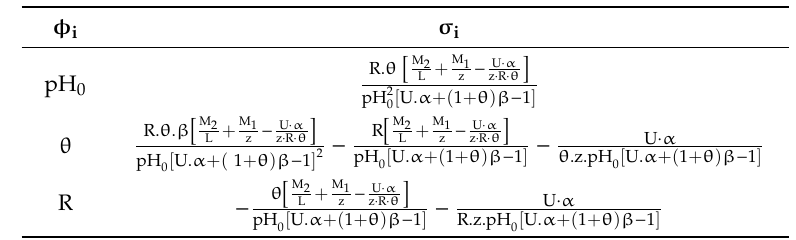
Table 4. Expressions of σ i for various parameters φ i , as defined in equation (33).